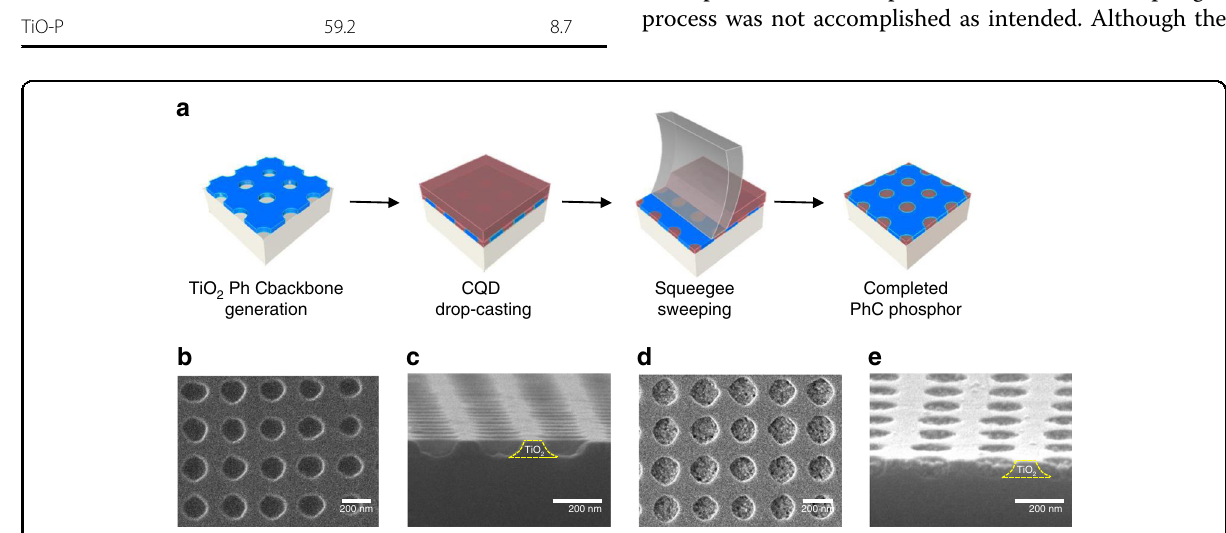
Fig. 2 Fabrication of the CQD-based 2D PhC phosphor. a Process fl ow depicted by the representative processing steps: 2D PhC pattern generation in the TiO 2 backbone layer, drop-casting of CQDs on top of the 2D PhC backbone structure, squeegee sweeping for the surface planarization, and the completed PhC phosphor. b – e SEM images of the 2D PhC phosphor: b , c before and d , e after the selective CQD incorporation into the air holes